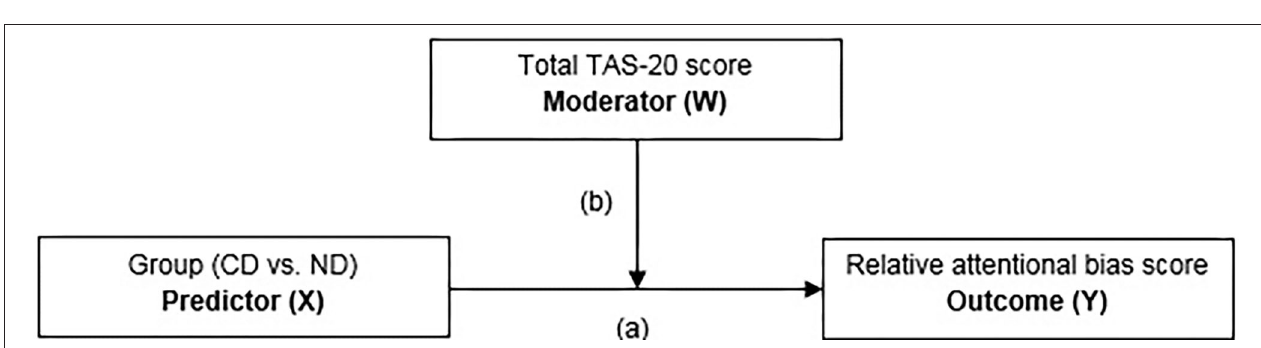
FIGURE 2 | Moderation model with group [currently depressed (CD) individuals vs. never depressed (ND) controls] as predictor (X), total TAS-20 score as the moderator (W), and the relative attentional bias score as the outcome (Y) variable.